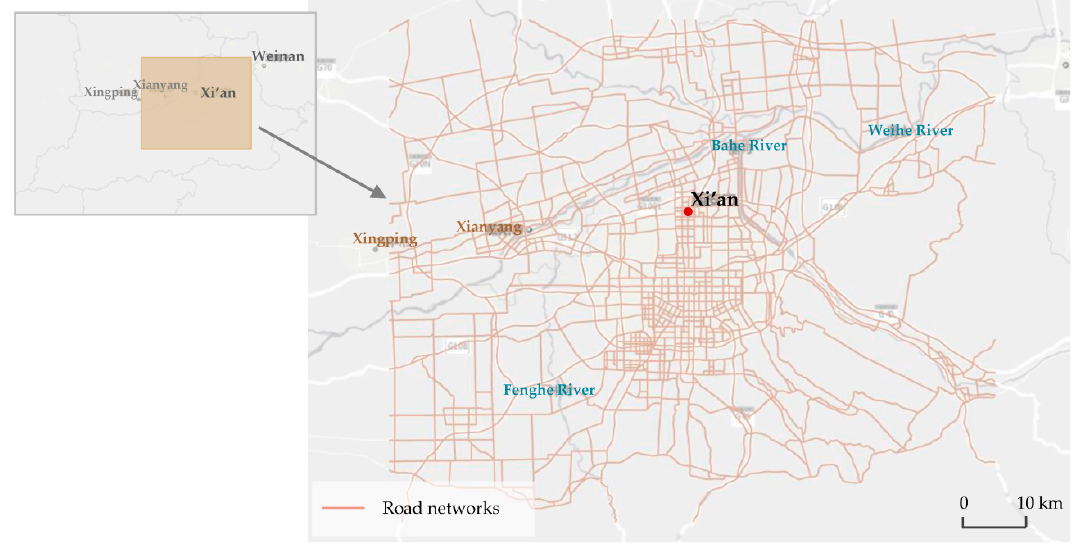
Figure 7. The study area and road networks in Xi’an.